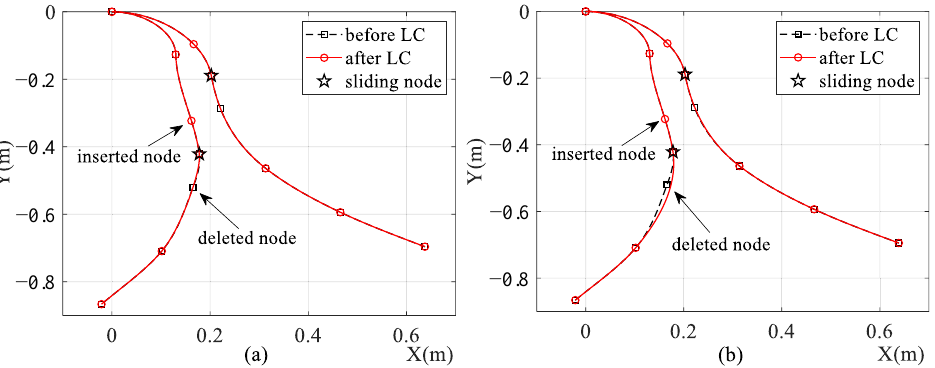
Figure 12. Configurations of ( a ) ALE-RANCF and ( b ) ALE-ANCF model before and after element length-control processes. LC is short for